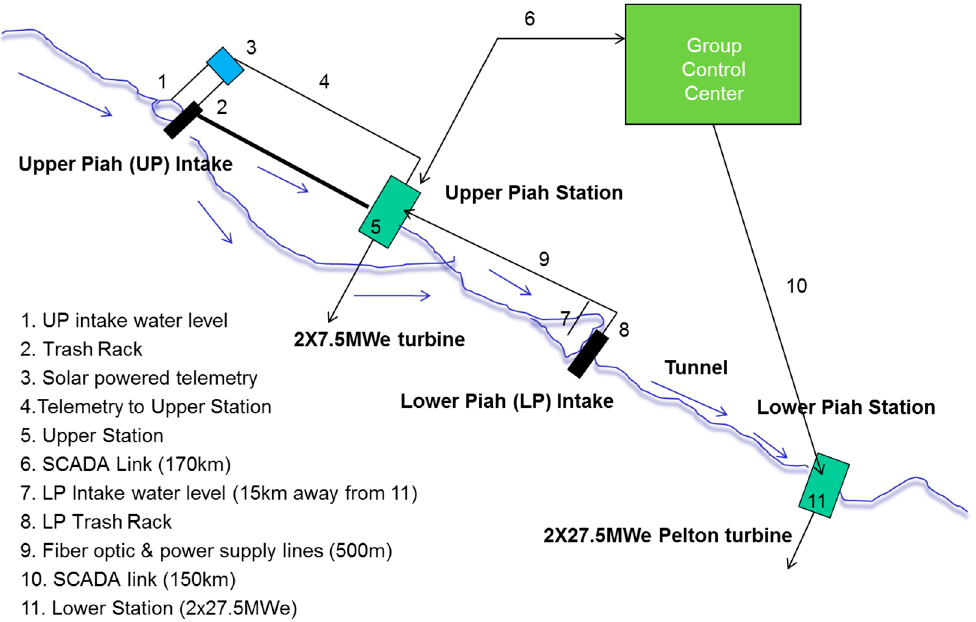
Figure 1. Cascaded run-off river hydroelectric system (upper and lower station).